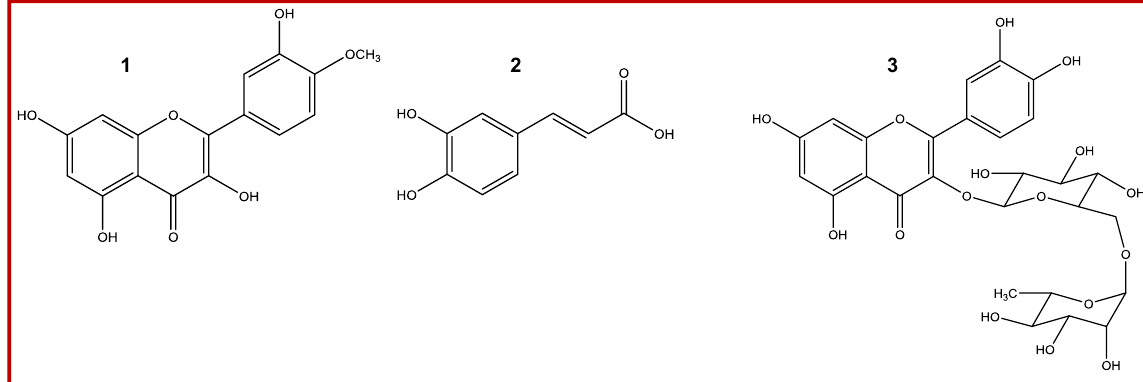
Figure 1: The structures of the isolated compounds